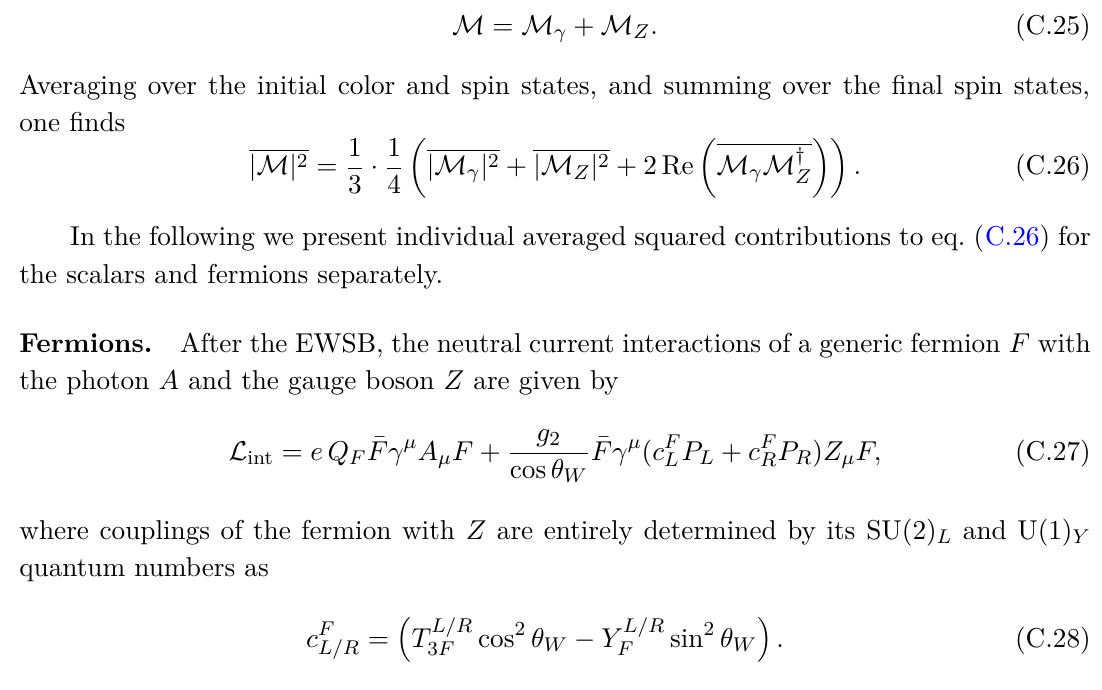
octets as solid blue C